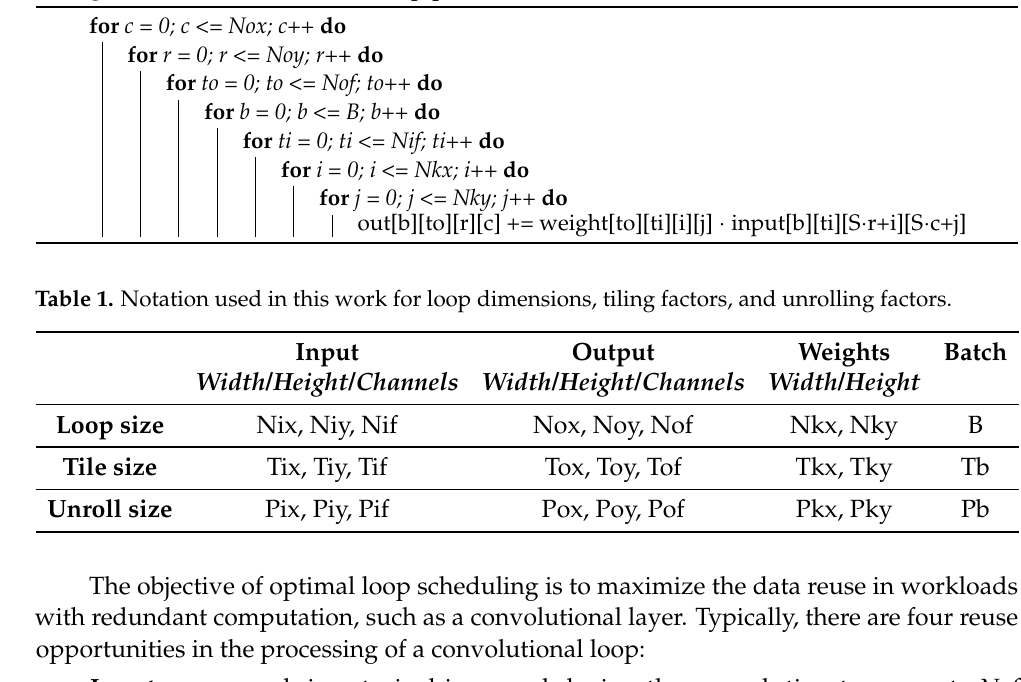
Algorithm 1: Convolutional loop pseudocode.